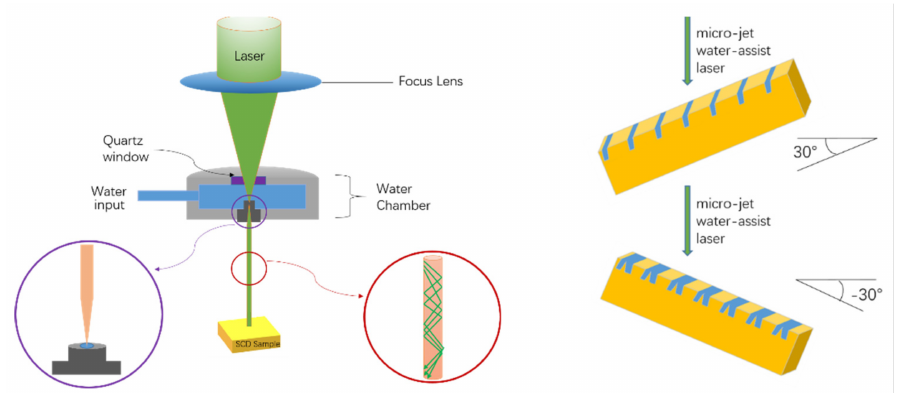
Figure 1. Schematic of the micro-jet water-assisted